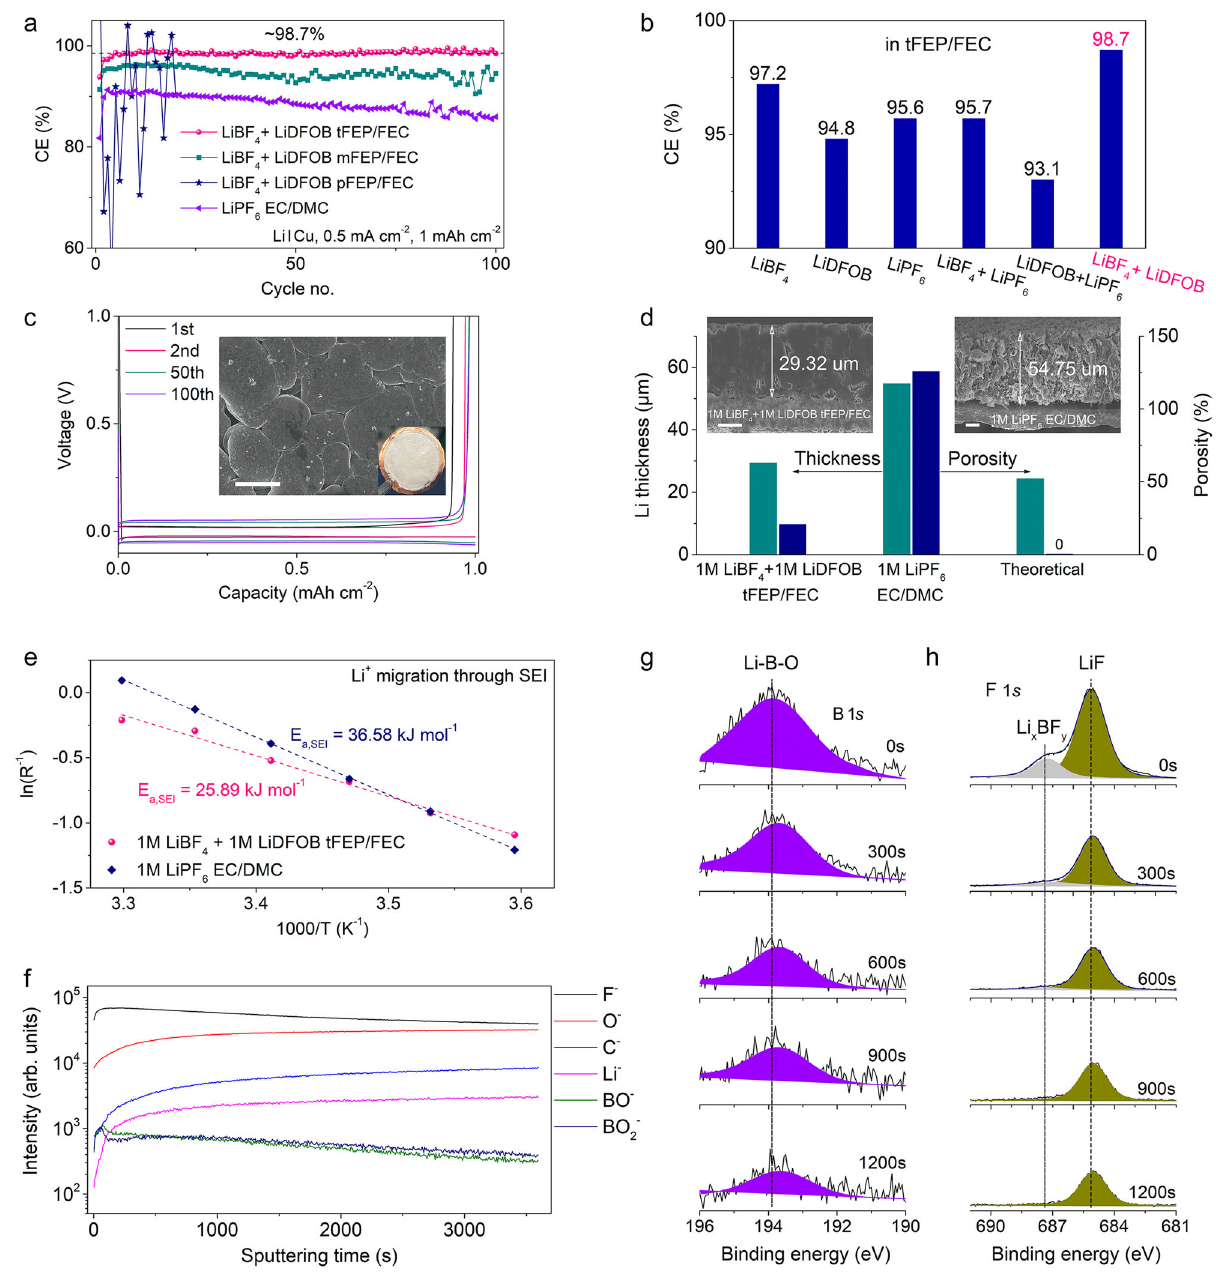
Fig. 3 | Electrochemical performance and characterizations of LMA. a , b Coulombicef fi ciencyforLideposition/strippinginLi/Cuhalfcellsusingvarious electrolytes at the current density of 0.5mAcm − 2 for the capacity of 1 mAh cm − 2 . c The corresponding deposition/stripping curves in 1M LiBF 4 +1M LiDFOB tFEP/ FEC electrolyte. Inset is the top view of Li morphology deposited on Cu foil. Scale bar: 10 μ m. d Electrode thickness and porosity of deposited Li calculated from focused ion beam-scanning electron microscopy(FIB-SEM) results.Inset arecross-